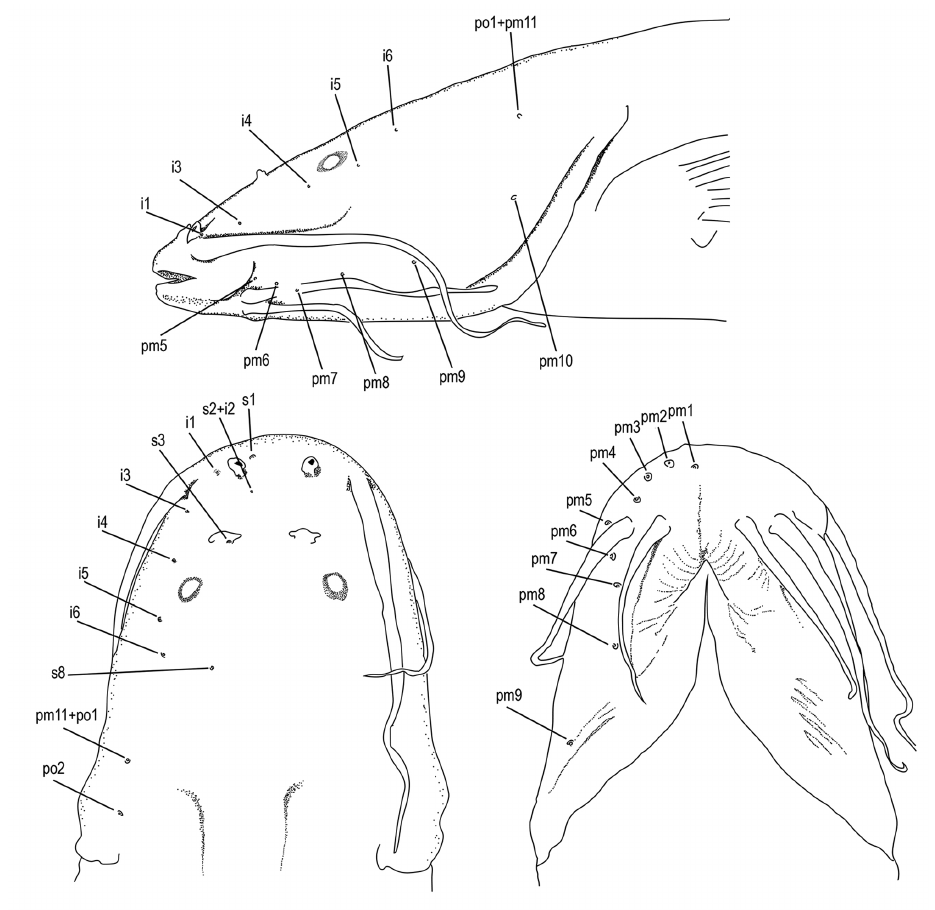
FIGURE 4 | Lateral, dorsal and ventral view of head of Phenacorhamdia suia , LBP 15886, 79.9 mm SL, paratype, showing the cephalic laterosensory pores. Infraorbital pores (i1–i6); Preoperculomandibular pores (pm1–pm11); Postotic pores (po1–po2); Supraorbital pores (s1–s3, and s8).